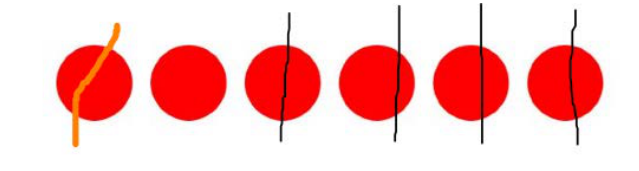
Figure 6 . Session 4: Problem 2 - Gerald